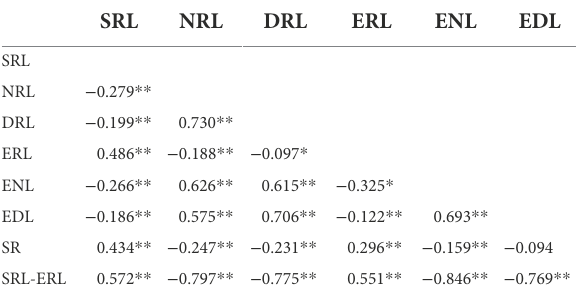
TABLE 14 Correlation between the types of internal and external regulation and the total score for the scale ( n =